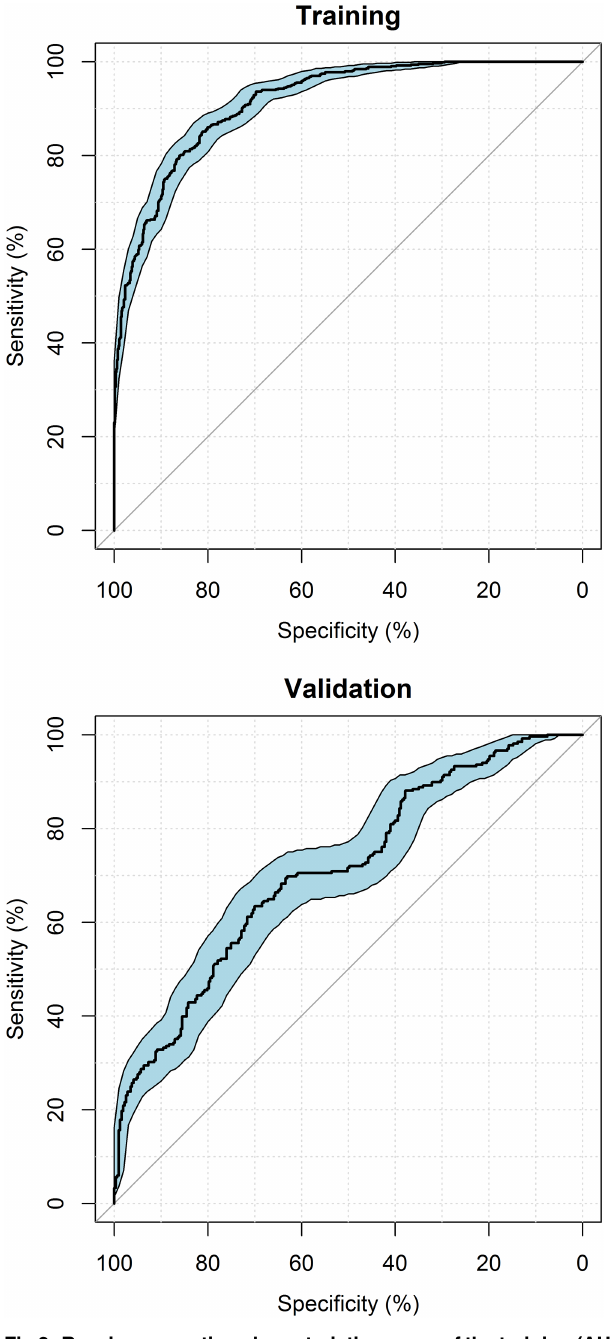
Fig 2. Receiveroperating characteristic curves of the training (AUC = 91.5%) and validation (AUC = 71%) models. The curved black line shows the sensitivity versus specificity of the multivariable logistic regressionmodels. The diagonallines describethe random line for a model with no predictive abilities. The blue shaded area representsthe 95% confidenceinterval.